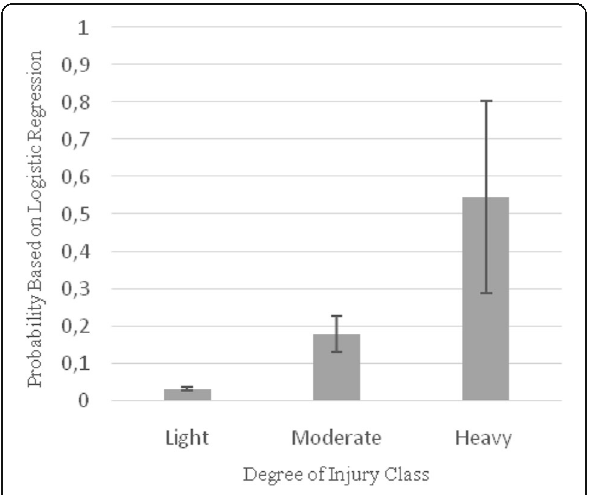
Fig. 3 Probability Class Degree of Injury Based on Logistic Regression Result. Degree of Injury Based on Logistic Regression, Fig. 3 shows if Y > 0.35 shows the degree of injury as severe injury, 0.15 – 0.34 is classified as the moderate injury, while for less than 0.15 is classified as